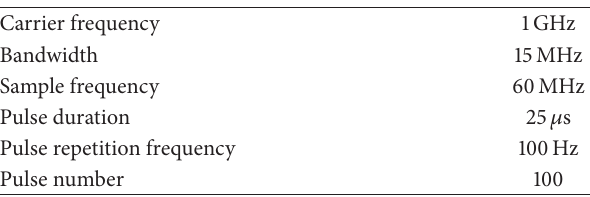
Table 1: Simulation parameters of